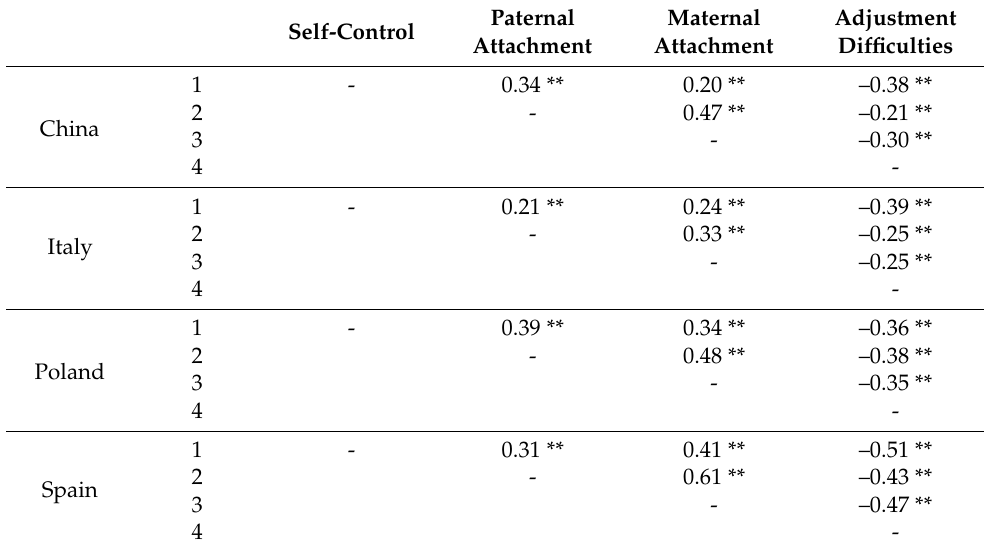
Table 2. Pearson’s correlations for the four countries.